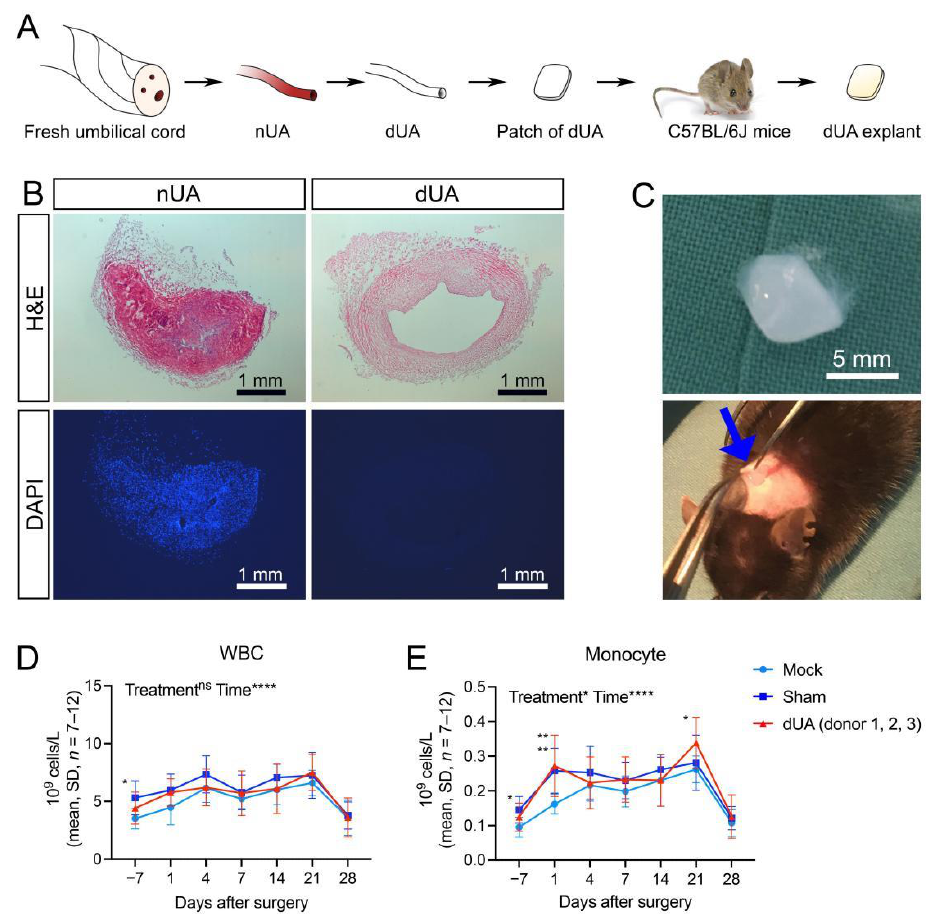
Figure 1. Implantation of decellularised umbilical artery (dUA) in mice. ( A ) Flow chart for the study design for subcutaneous implantation of a human dUA patch into mice. Human native umbilical artery (nUA) was dissected from fresh umbilical cord and decellularised by a 3-day protocol. The dUA was cut into small patches and subcutaneously implanted in mice and explanted after 28 days. ( B ) Haematoxylin and eosin (H&E) and DAPI staining of nUA and dUA, showing efficient decellularisation. ( C ) Representative images of a 5 × 5 mm dUA patch inserted in a subcutaneous dorsal pocket (marked by blue arrow) on a C57BL/6J mouse. ( D , E ) White blood cell (WBC) and monocyte count in peripheral blood was monitored 7 days before and at 1, 4, 7, 14, 21, and 28 days after implantation. The effect of treatment (mock, sham and dUA) and time after surgery were analysed by mixed-effects analysis (post-test: Tukey test) for statistics (mock: n = 7; sham: n = 8; dUA: n = 3 ( n * = 4)). See also Supplementary Figure S1 for replicate dUA donor measurements. * p ≤ 0.05, ** p ≤ 0.01, **** p ≤ 0.0001, ns p >